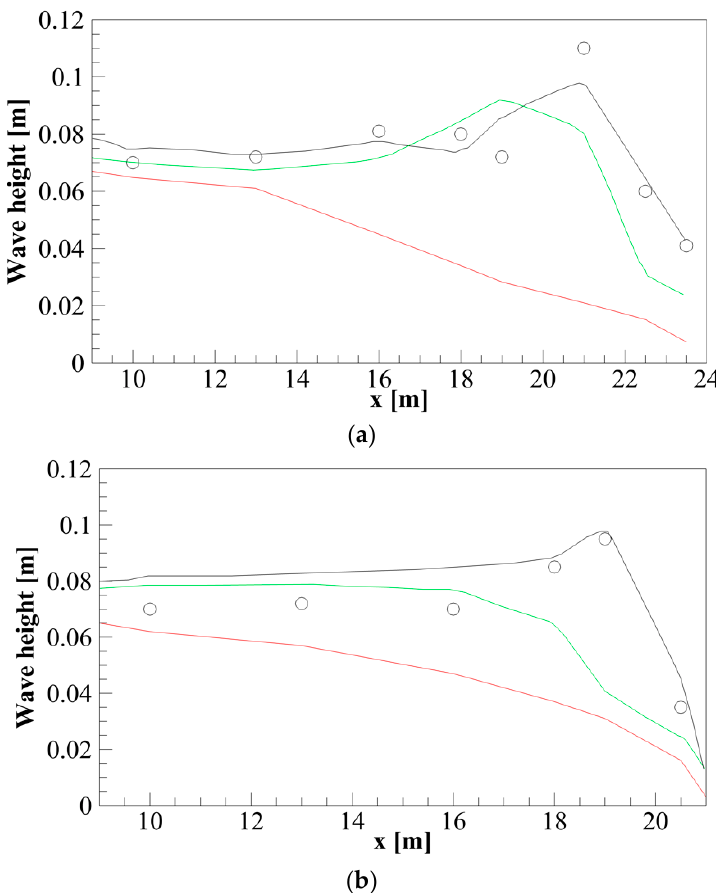
Figure 10. Test 4. Rip current. Wave height. Comparison between experimental and numerical results: significant wave height from Hamm [24] (circles); mean wave height obtained with the WTENO model (black line), the 2TVD model proposed by Cannata et al. [3] (red line), and the 5WENO model (green line). ( a ) Section A, along the rip channel; ( b ) Section B, along the cross-section of the 1:30 sloping beach.